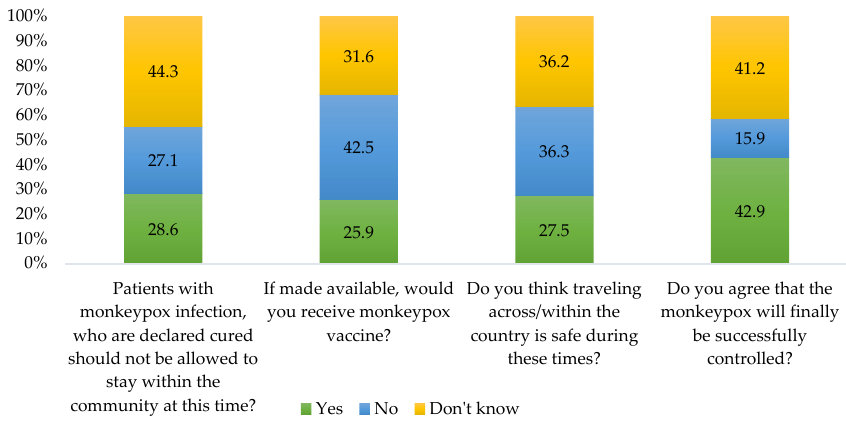
Figure 2. Attitude of participants about mpox viral infection ( n = 510).